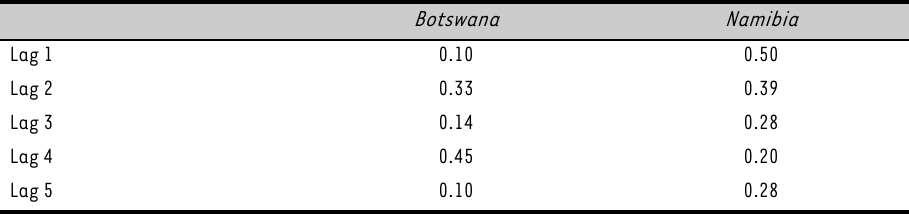
LMF test (p-values) Botswana Namibia Lag 1 0.10 0.50 Lag 2 0.33